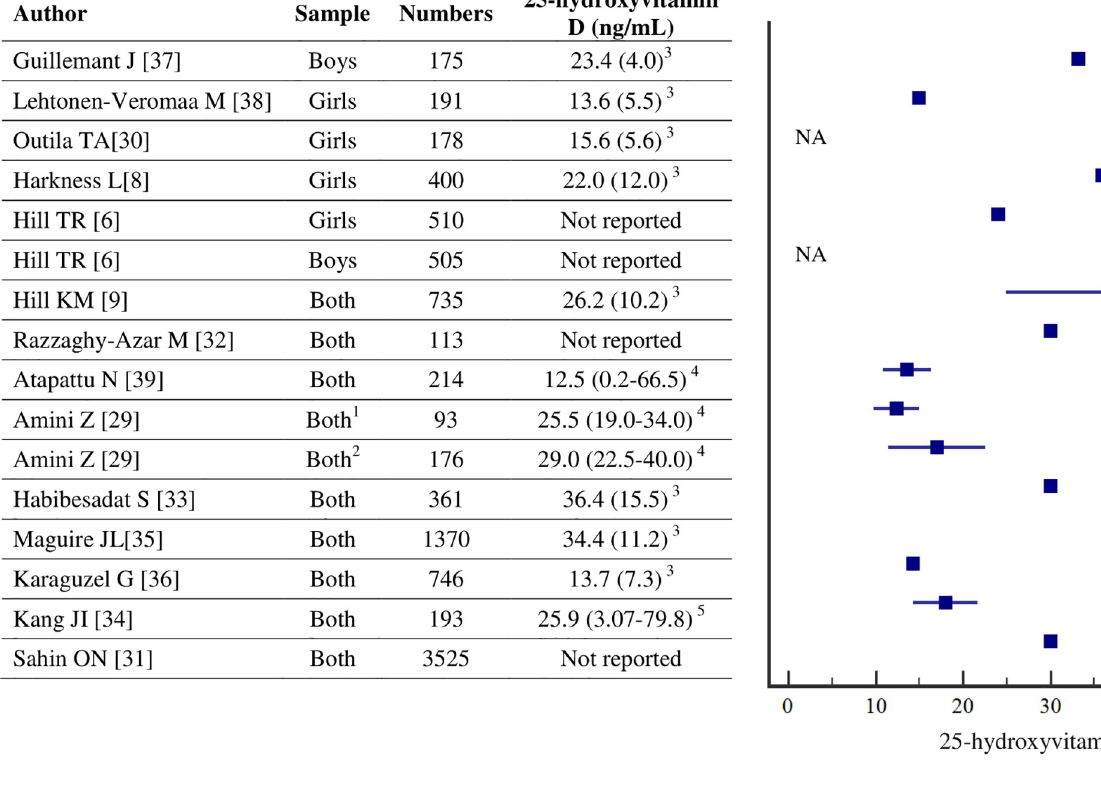
PLOS ONE | https://doi.org/10.1371/journal.pone.0225717 November26, 2019 10 /